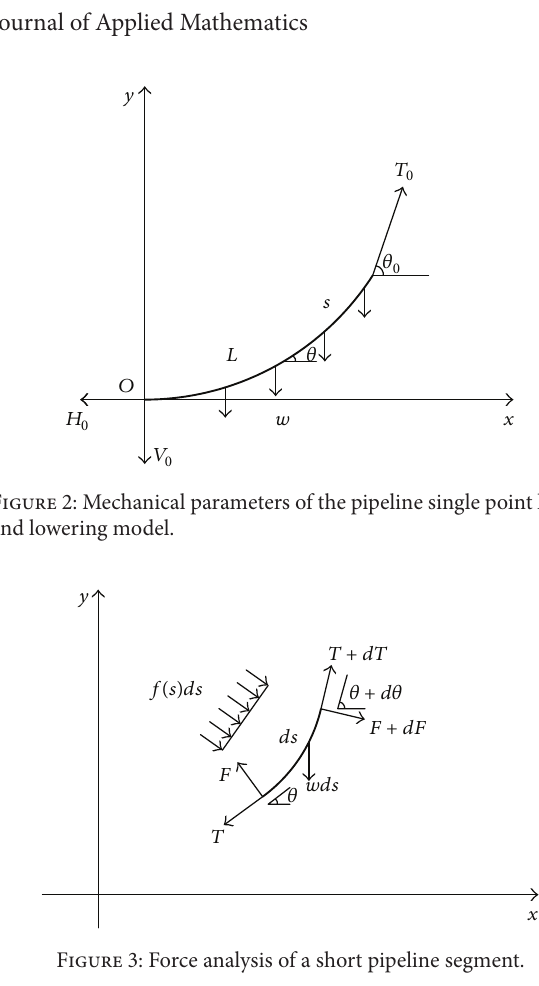
pipeline lifting and the ending stage of pipeline lowing